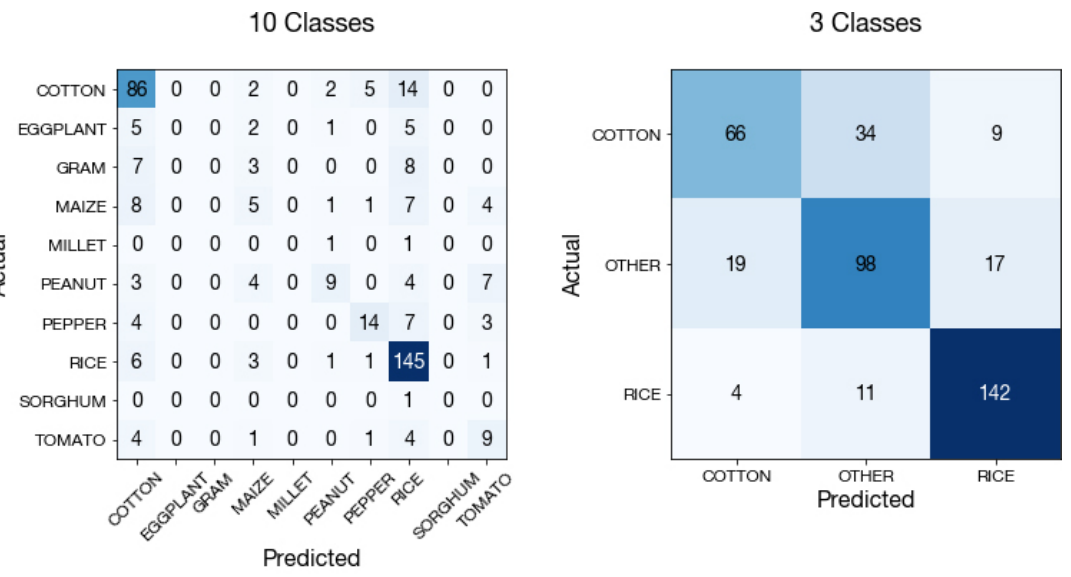
Figure A13. Crop type classification confusion matrices on the 10-class task and the 3-class task. Values are shown for the test set ( n = 400).